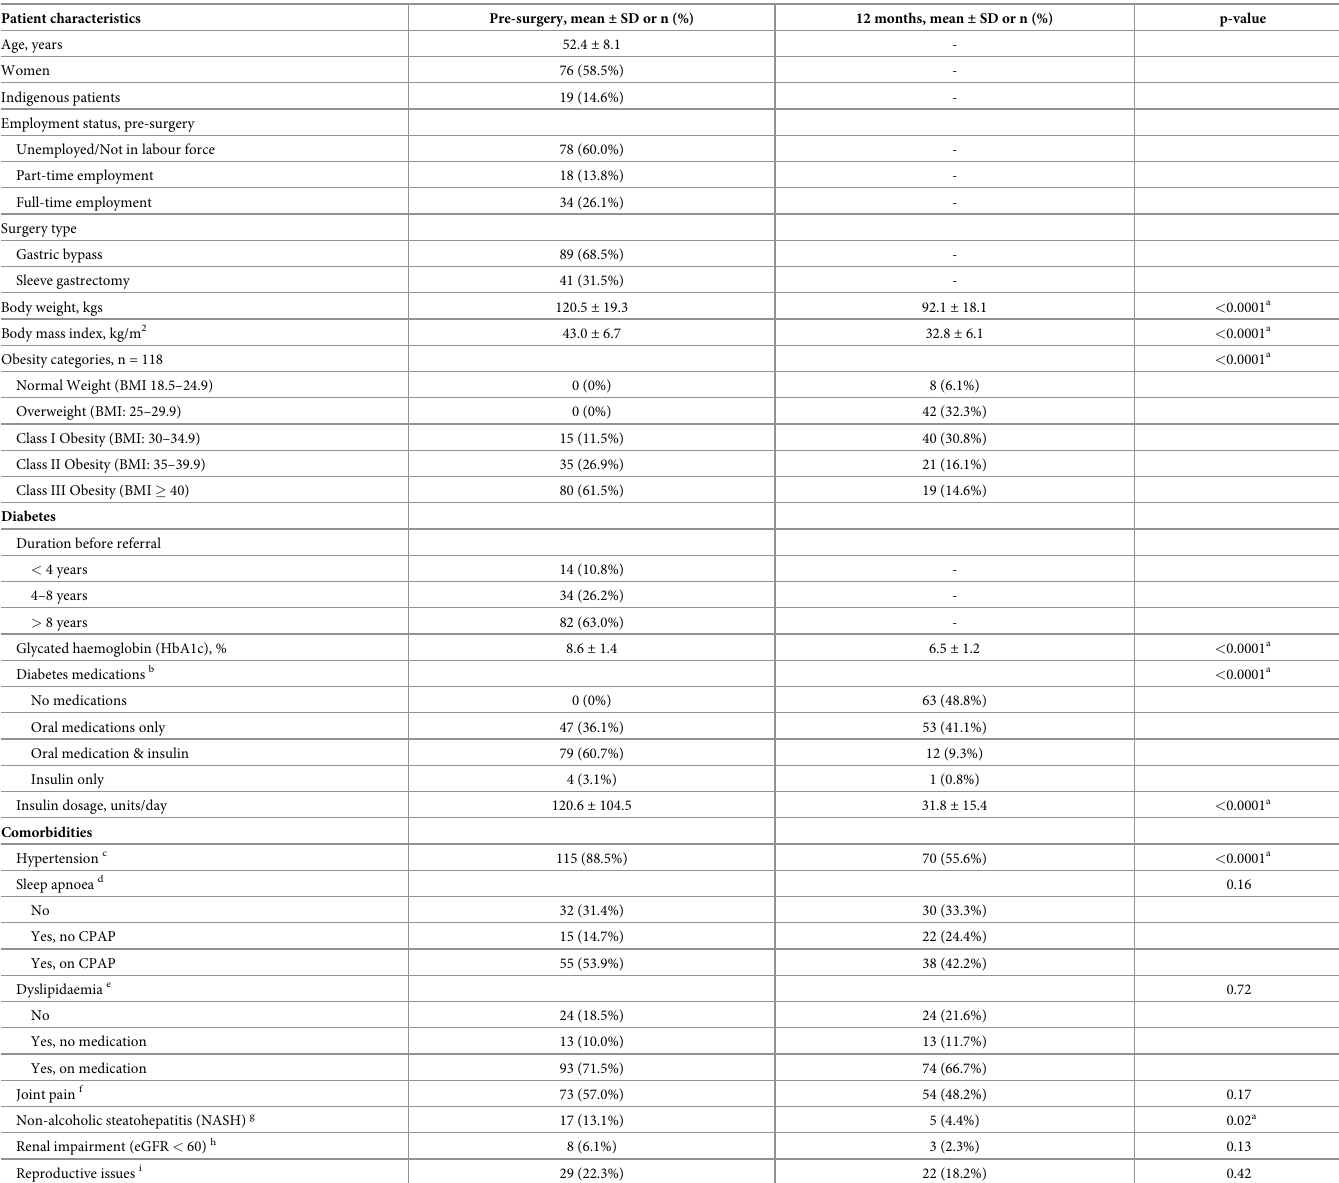
Table 1. Clinical characteristics and outcomes of patients who underwent bariatric surgery and had follow-up data at 12 months post-surgery (N = 130).